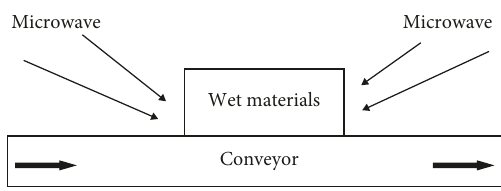
Figure 2: Schematic of microwave heating.